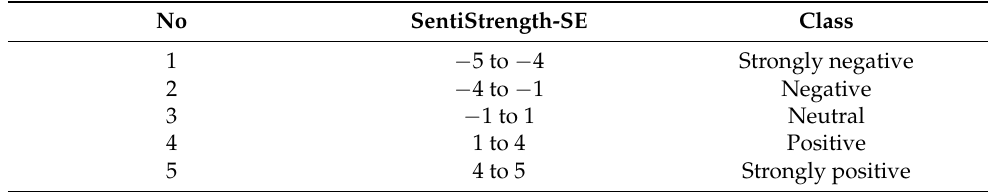
Table 2. Sentiment analysis